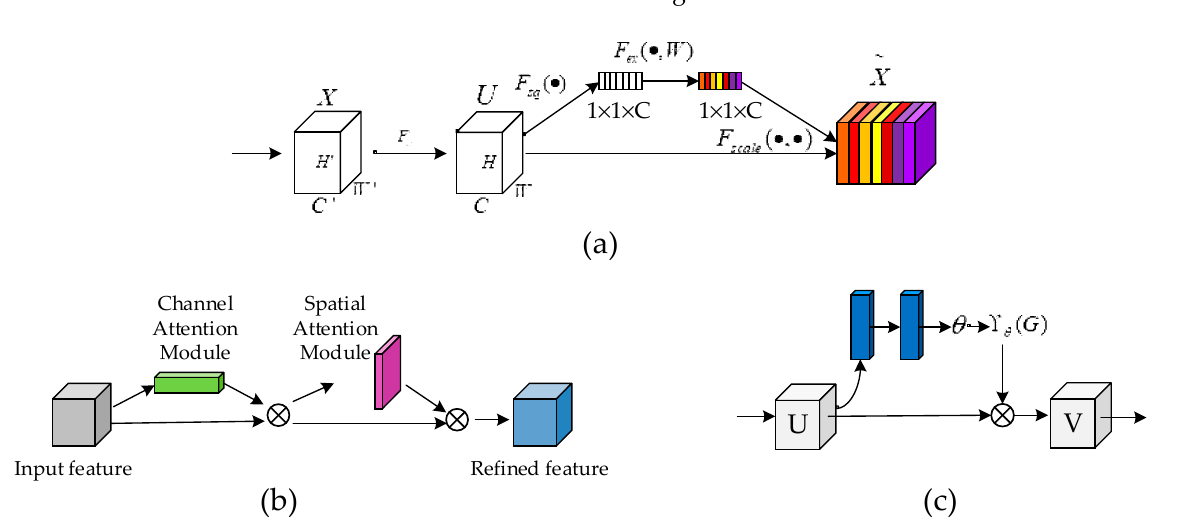
Figure 3. Structure of several typical attentional networks (from left to right SENet [18], CBAM [47] and SpatialNet [48], respectively). CBAM (convolutional block attention module), where ( a ) the main focus is on channel relationships between image input features, ( b ) the main focus is on integrating spatial and channel attention, and ( c ) the main focus is on spatial relationships between image features.